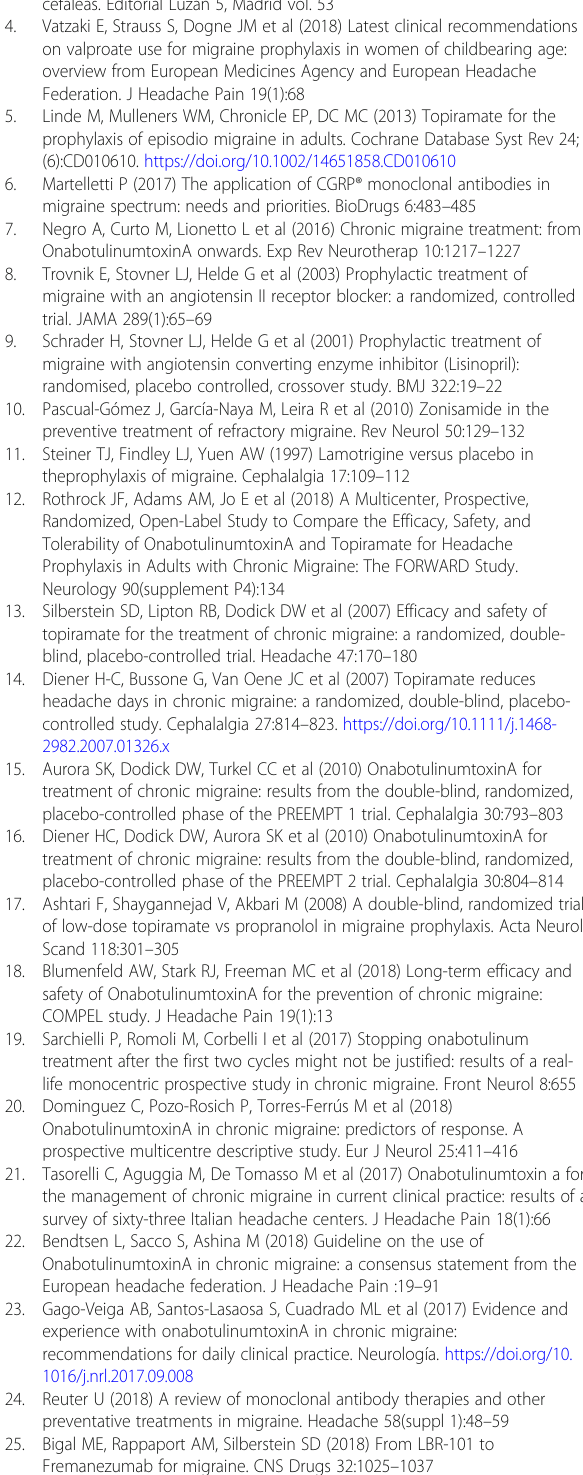
percentage of total responses. Table S4. Perception about efficacy of the different drugs in the treatment of chronic migraine. Numbers represent percentage of the answers. Table S5. Perception about efficacy of the different drugs in the treatment of episodic migraine. Numbers represent percentage of the answers. Table S6. Answers about the drugs considered as the best tolerated and second best tolerated. (DOCX